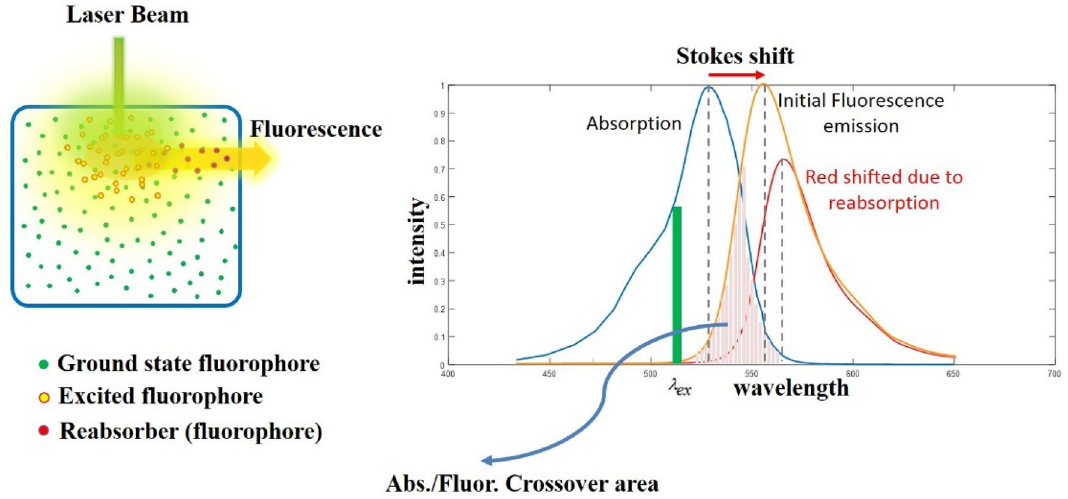
Figure 1. Left: Typical fluorescent medium excited by a narrow laser beam and associated fluorescence emission that is detected at right angle setup (90°); Detected LIF emission is subjected to reabsorption events. Right: Typical absorption–emission spectra of Rd6G dye solution and associated crossover area (hatched). Detected fluorescence peak wavelength is red shifted respect to the initial one, because the reabsorption events preferentially occur at shorter wavelengths of the fluorescence spectrum.